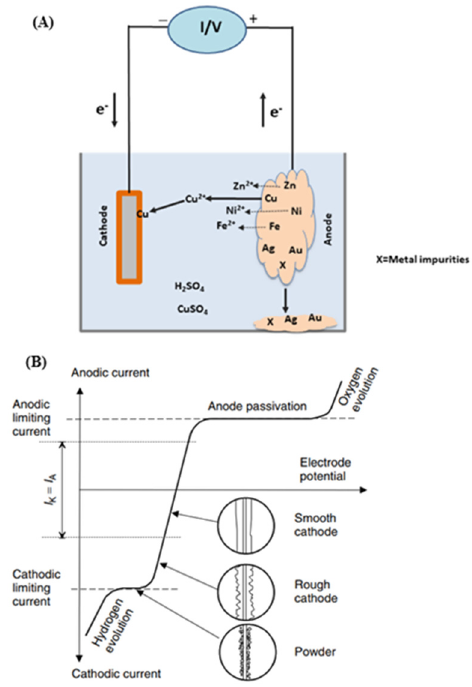
Figure 8. Schematic description of electrorefining process ( A ) and current density–cell voltage dependence for the electrorefining of copper ( B ). Reproduced with permission [16]. Copyright 2007,